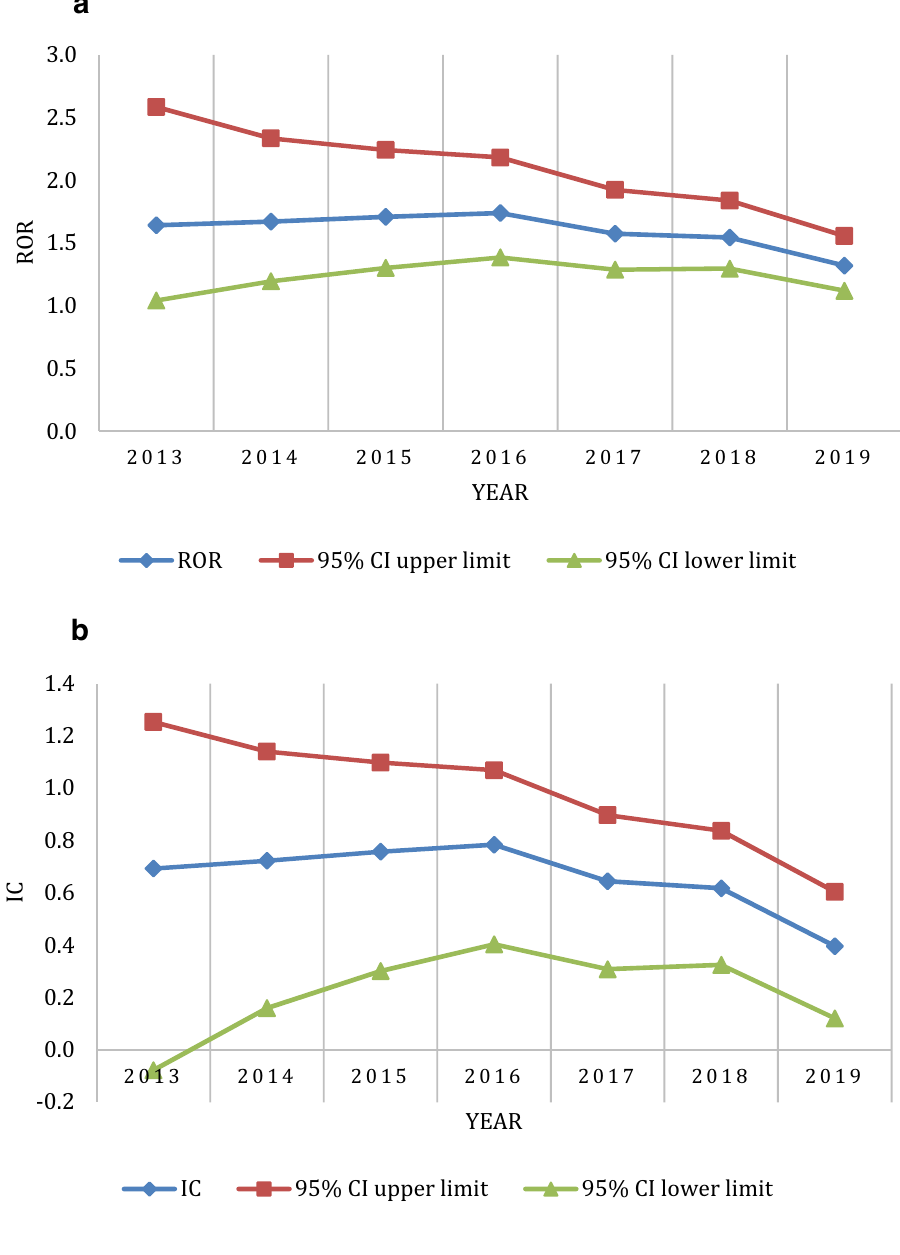
Figure 1. Cumulative change in the reporting odds ratio (ROR) ( a ) and information component (IC) ( b ) values for suspected tocilizumab-induced pancreatitis reported to United States food and drug administration adverse event database from 2013 to